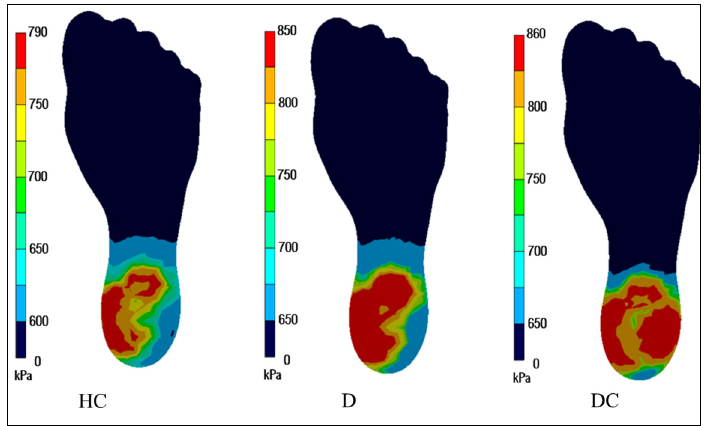
Figure 11. Plantar pressure distribution across the HC, D, and DC group during heel strike.